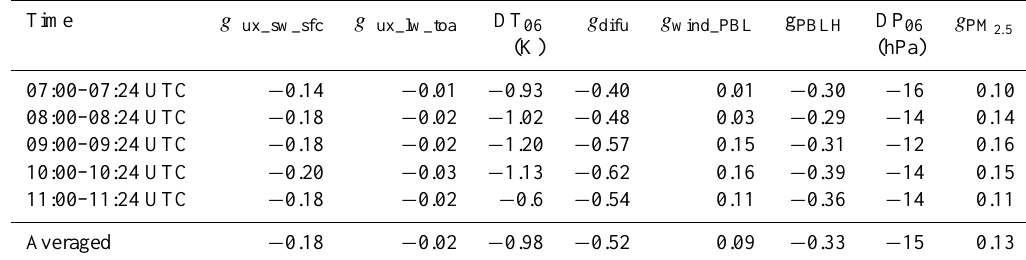
Table 1. Weighing coefficient of the response of meteorological parameters to aerosol DRF. Time g flux_sw_sfc g flux_lw_toa